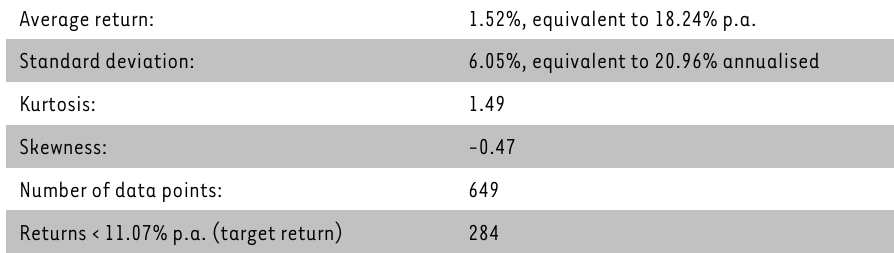
Volatility analysis of the